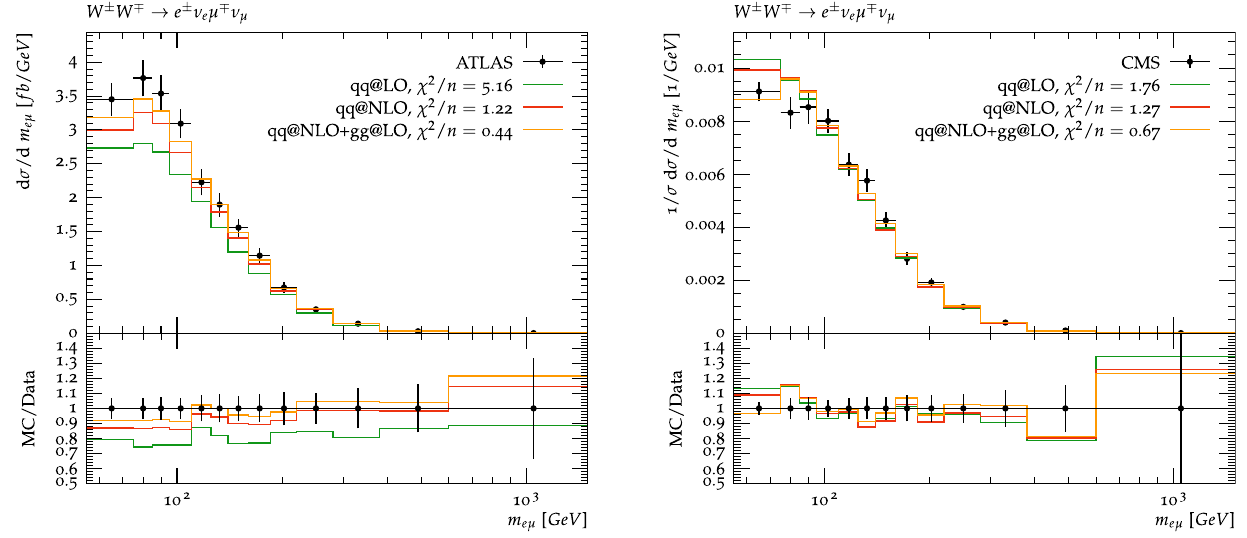
√ s = 13 TeV from ATLAS (left) and CMS (right panel).